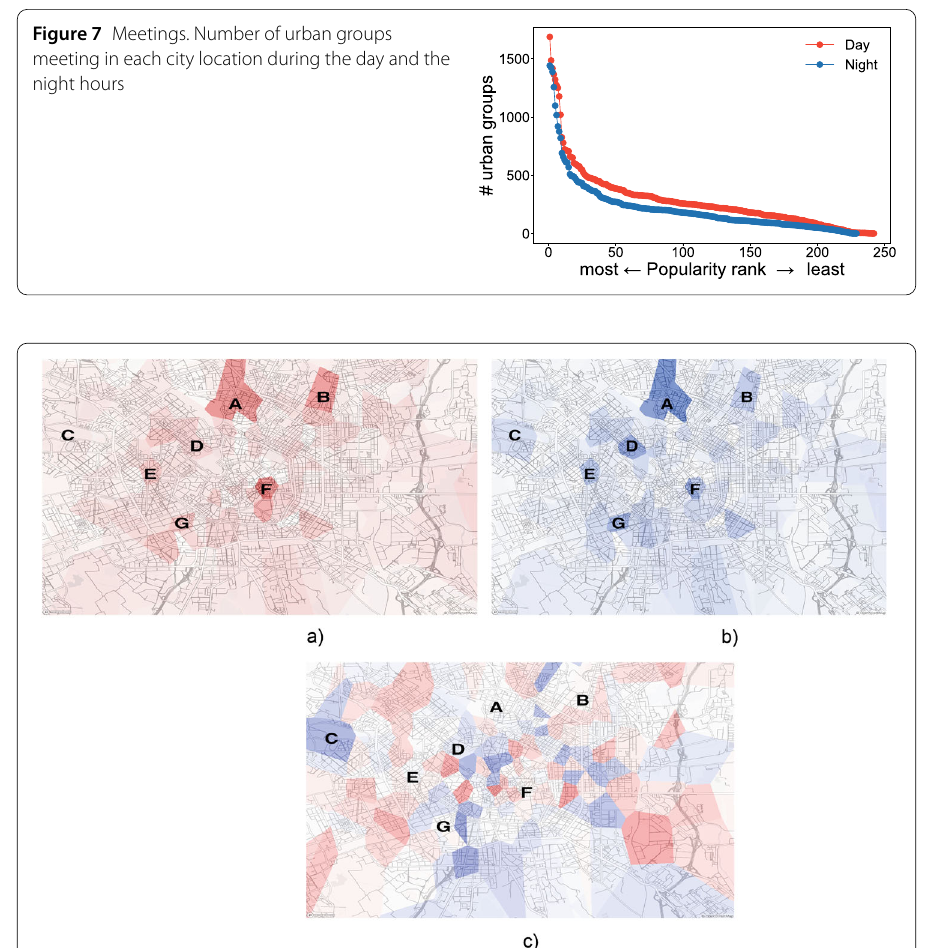
Figure 8 Location popularity. ( a ) The heatmap of the location popularity during the day hours. ( b ) The heatmap of the location popularity during the night hours. ( c ) The heatmap of the rank difference, red means that the location loses popularity between day and night, while blue means that the location gains in popularity, the color intensity reflects the absolute value of the rank difference of the